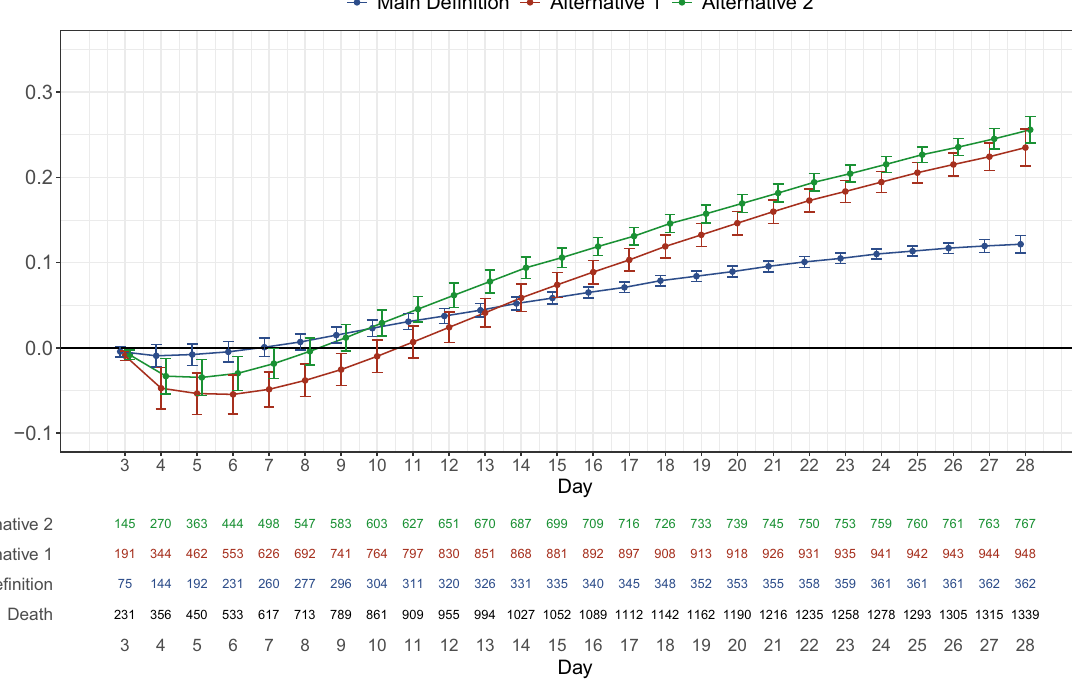
Fig. 3 Comparison of the three definitions for medical admissions. Upper panel: the daily odds ratio for mortality in medical patients according to the definition used. Bottom panel: the respective AF for each definition. Note that a higher OR does not equal higher AF due to changes in